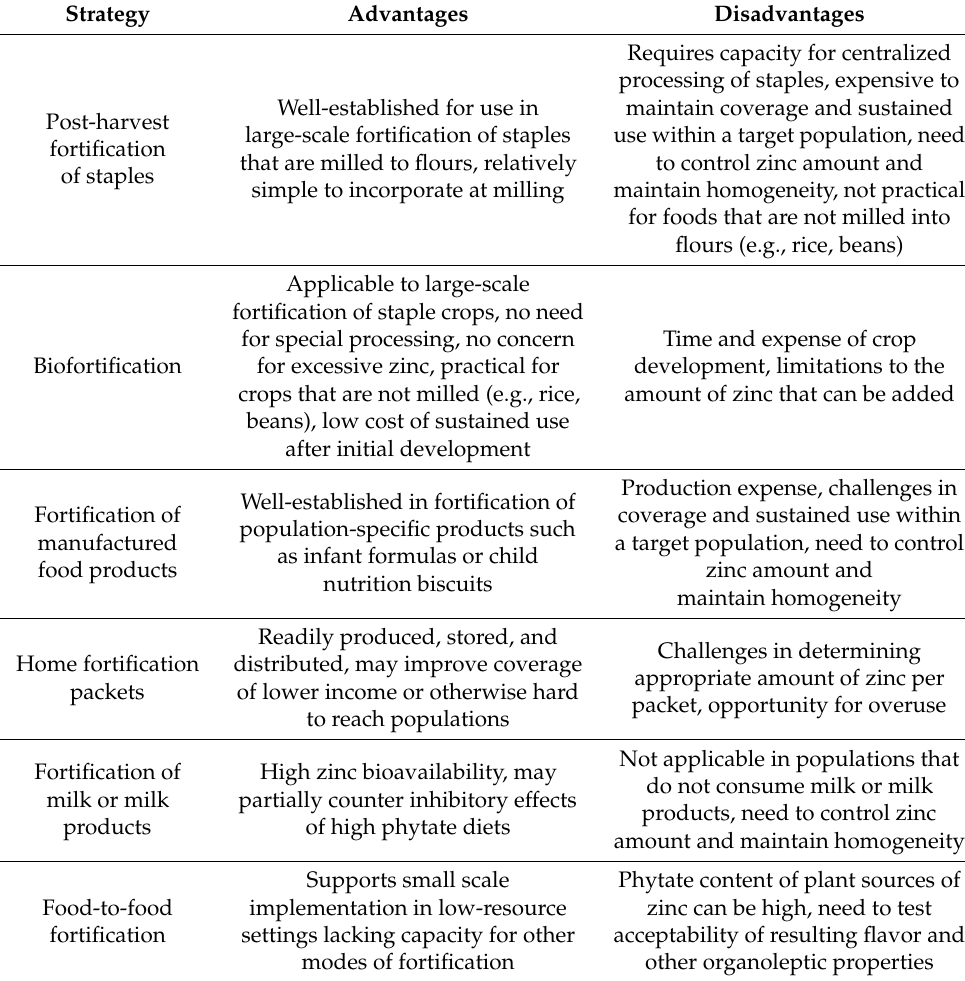
Table 1. Comparison of recent zinc fortification